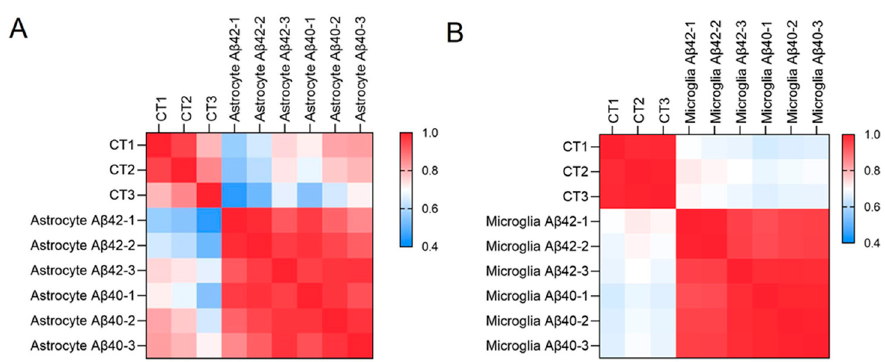
Figure 3. Heat maps of a Pearson correlation between control, untreated cultures, and fibril treated cultures. ( A ) astrocytes and ( B ) microglia. Data are calculated based on the whole gene counts from astrocyte and microglial RNA sequencing profiles, separately.